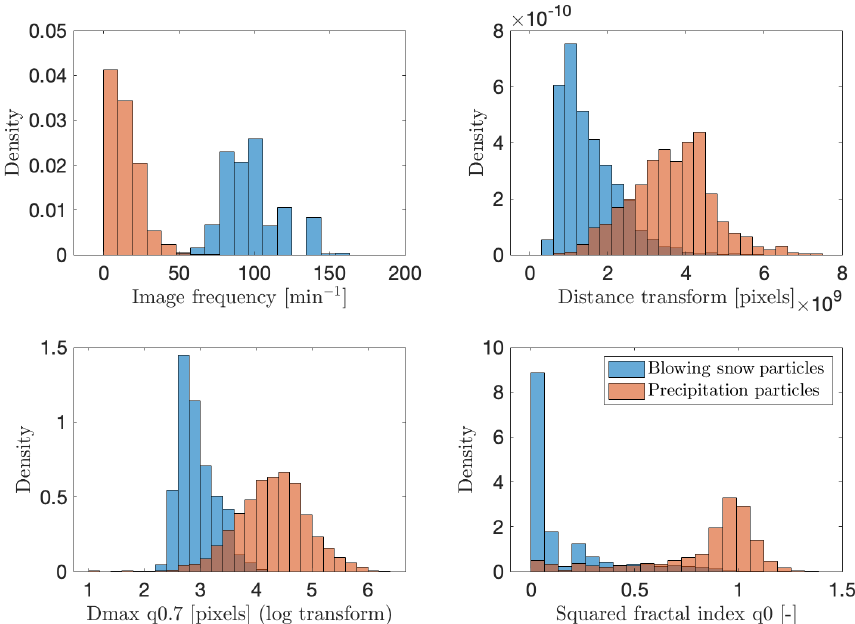
Figure 6. Histograms of selected descriptors for the training blowing snow and precipitation